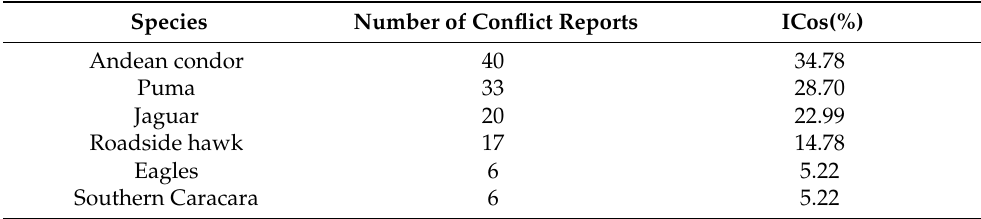
Table 2. Number of interviewees that reported the existence of conflict and conflict indexes (ICos) for each species or group of species (i.e., eagles). Only conflicts with ICo ≥ 5% are included. Species Number of Conflict